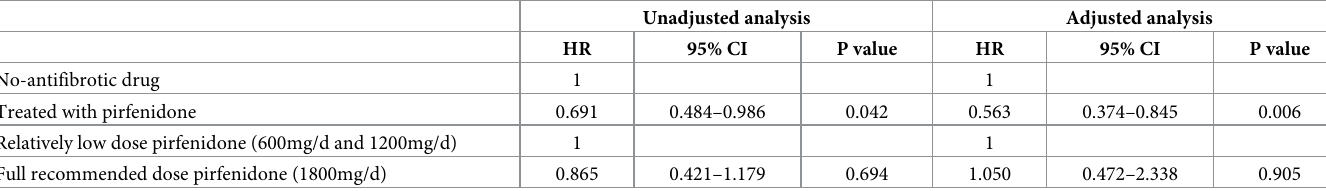
Table 3. Effects of pirfenidone treatment on mortality using Cox proportional hazard regression model.